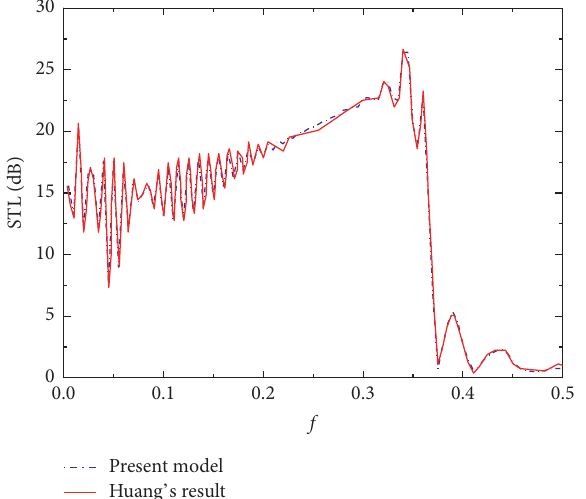
Figure 2: Sound transmission loss of one membrane setup. Figure 3: Comparison of STL for radiated sound pressure at x � 5.